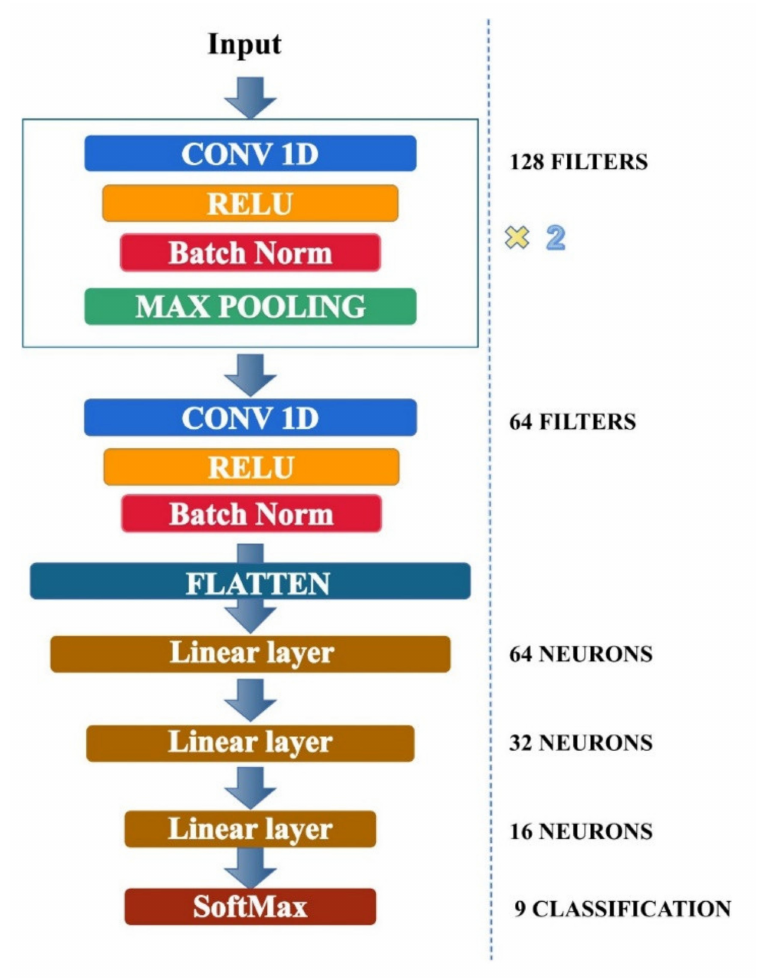
Figure 2. Emotion recognition